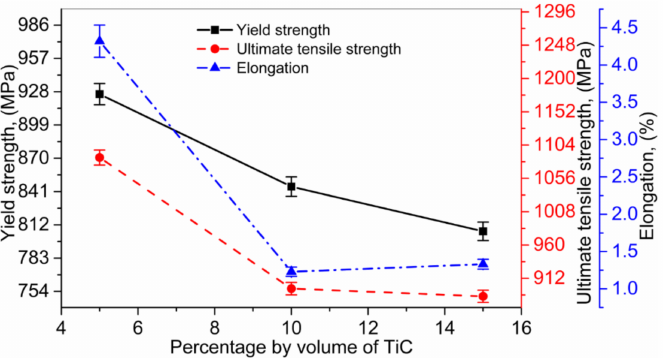
Figure 14. Effect of vol.% of TiC on: yield strength, ultimate tensile strength, and elongation; based on the data from [99].